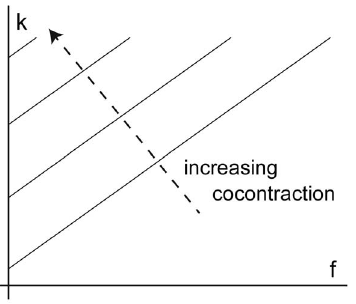
Figure 2. Cross sectional view of the Grasp Perturbator.